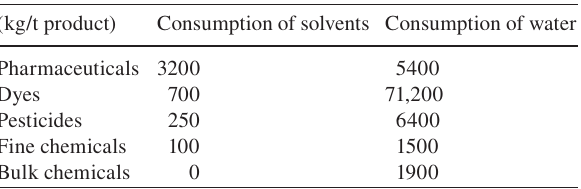
Table 1 Consumption of solvents and consumption of water in different branches in kg per ton product [19] .